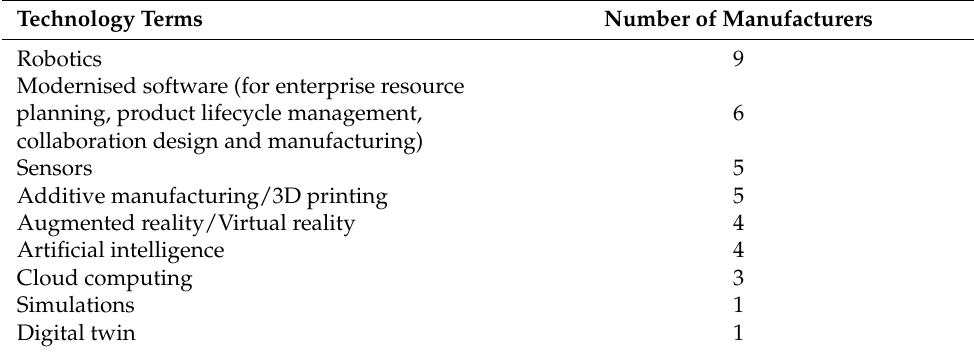
Table 4. Industry 4.0 technologies mentioned by Australian